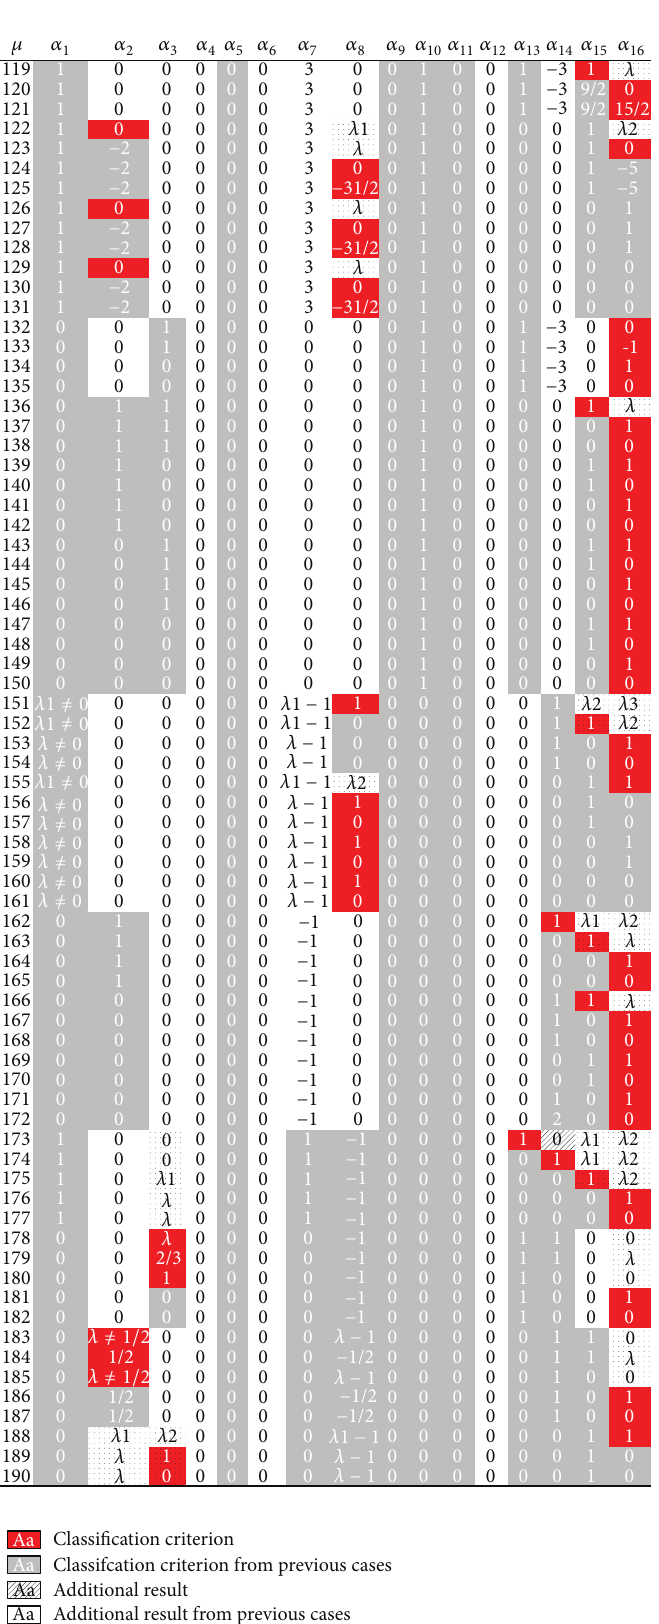
Figure 6: Case B.2.2. First part: 𝛼 11 = 0 , 𝛼 9 = 0 , and 𝛼 5 = 0 . Classification of the QFLA of dimension